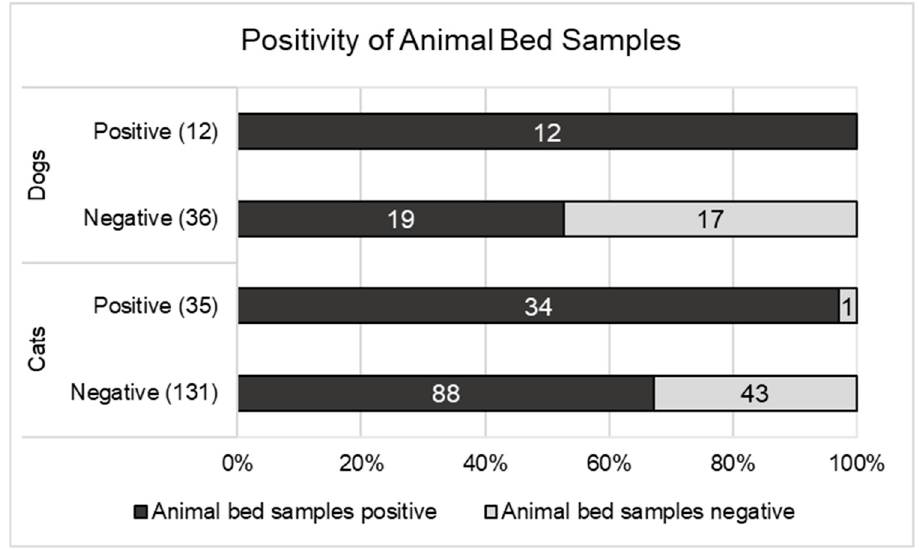
Figure 3. Distribution of positive bed samples for SARS-CoV-2-positive and SARS-CoV-2-negative dogs and cats. dogs and